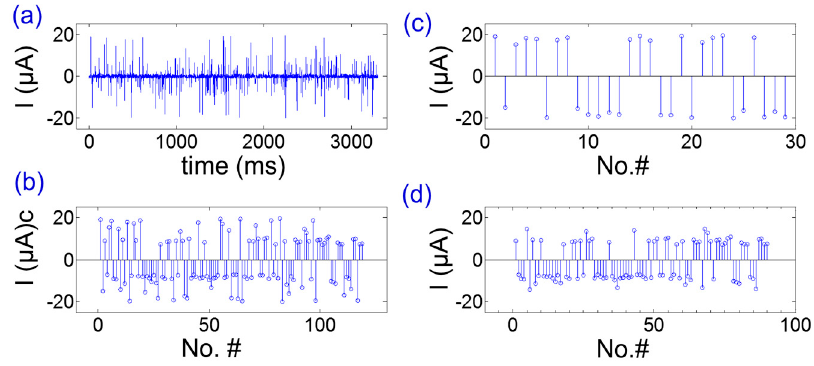
Figure 5. The experimental results of latex particle counting applications as a proof of concept. ( a ) The real-time current signal obtained from the impedance analyzer. ( b ) Real-time current signals processed by a customized filter. Here, the signals smaller than the threshold were cut o ff as zero. ( c ) The current signal response of 10 µ m particles. ( d ) The current signal response of 5 µ m